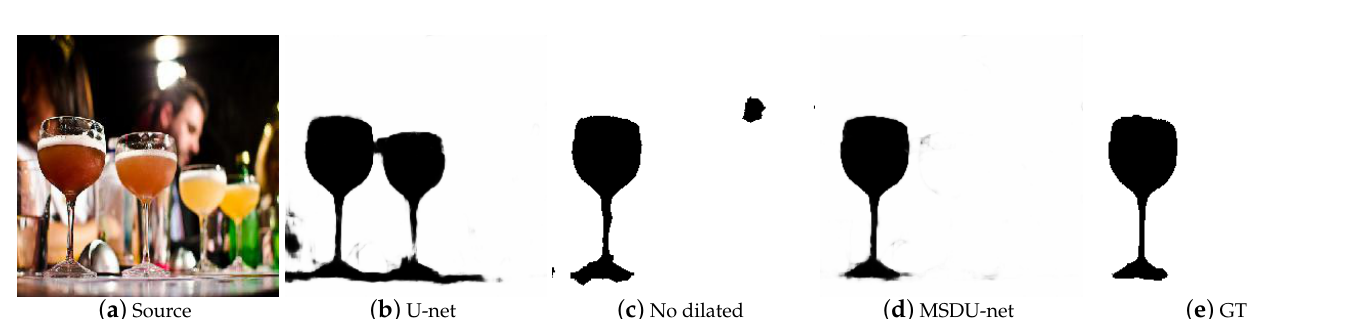
Figure 8. Visual comparison results among no dilatited (using 5 × 5 normal convolution kernels), our model and